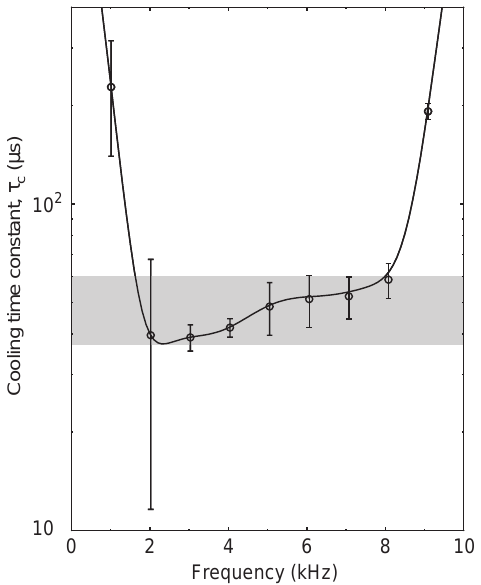
Fig. 14. Cooling time constants derived from first nine even harmonics of 505 Hz. Grey shaded area shows range in which more than 75% of data points are accommodated